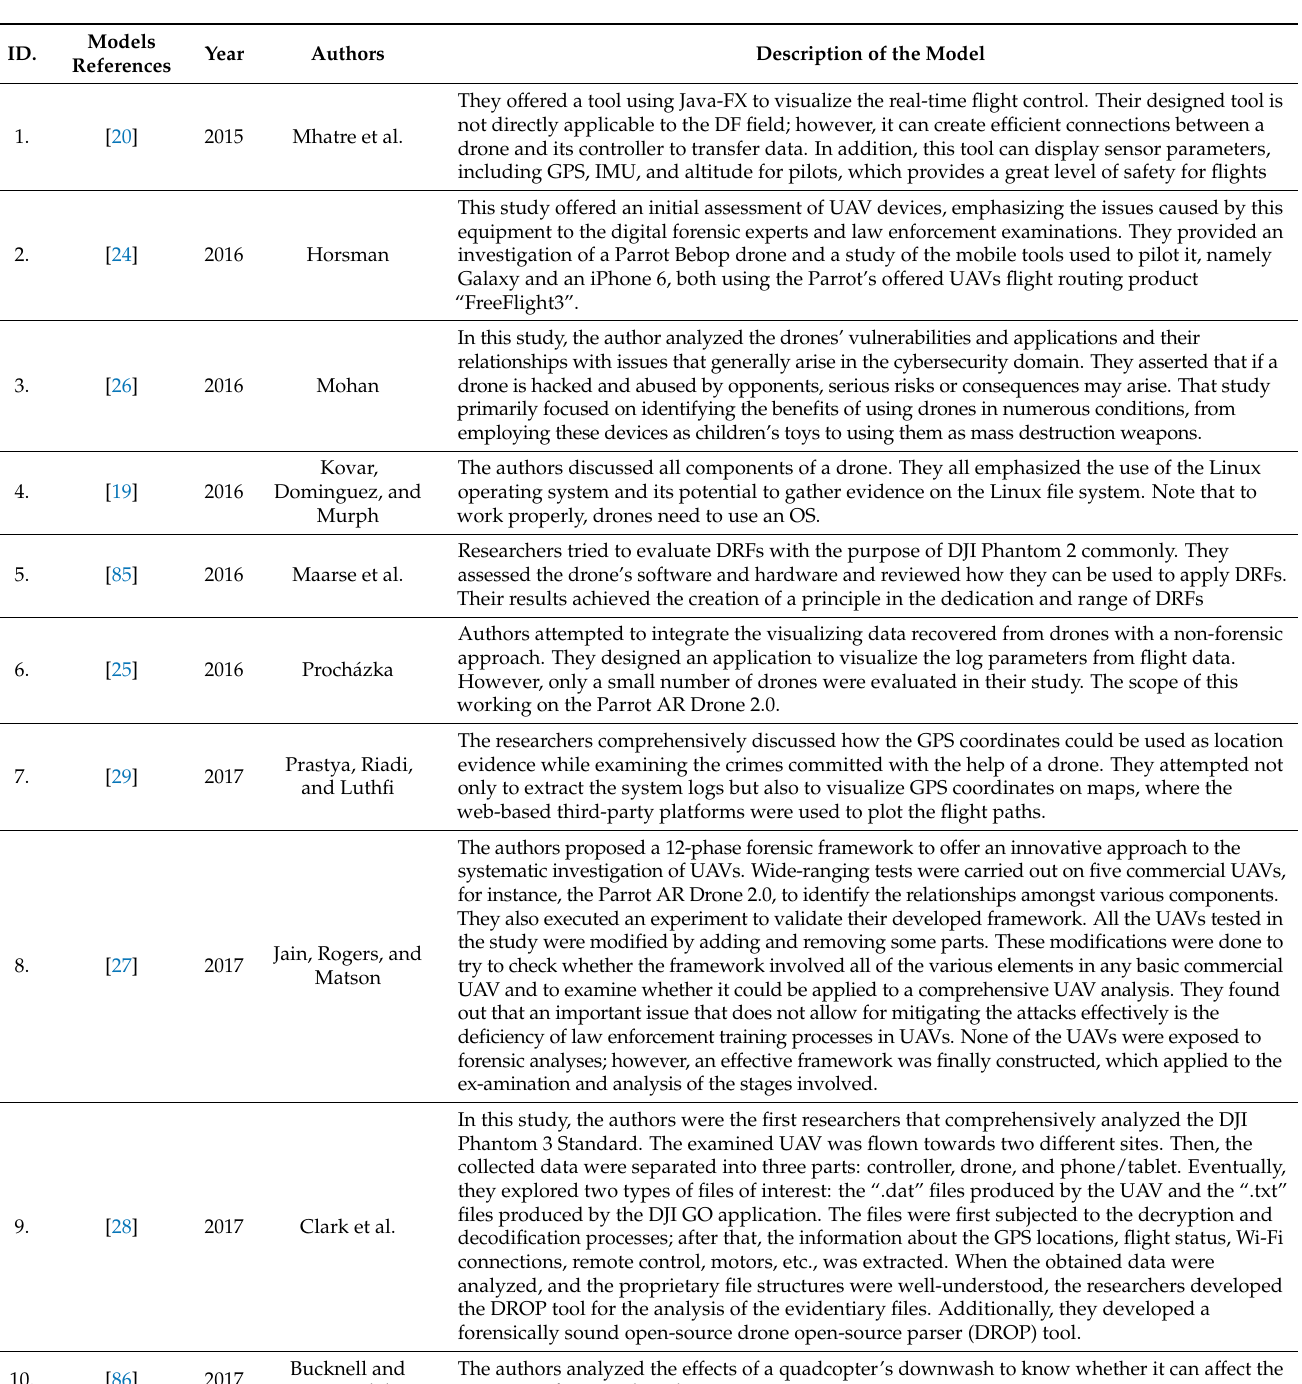
Table 1. Recognized and nominated drone forensics